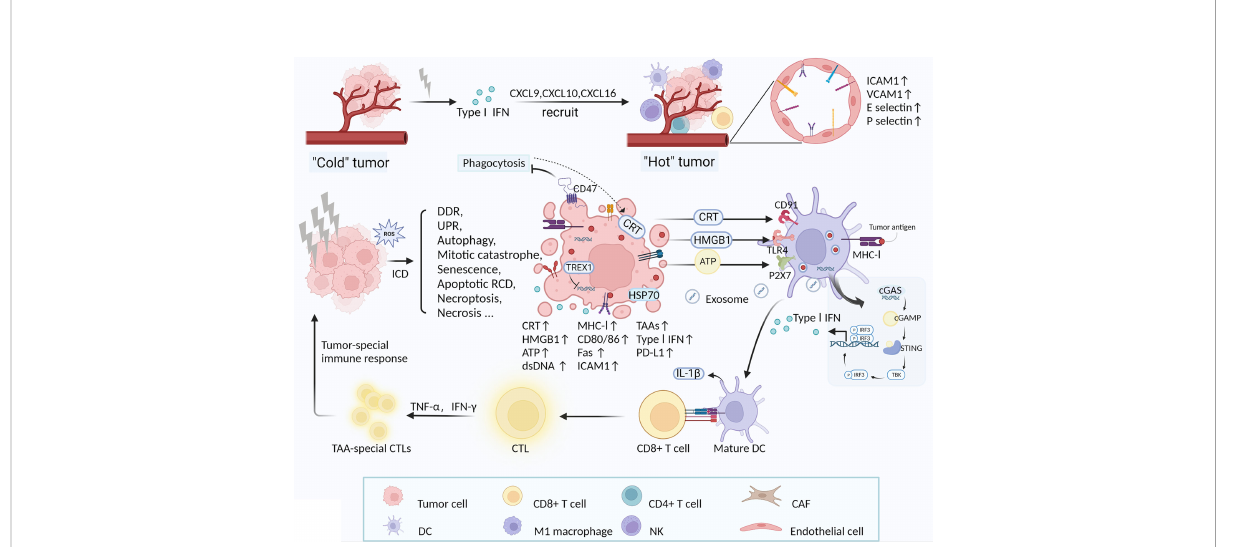
FIGURE 2 RT-induced increase in immune cells in TIME and tumor-special immune response activated by ICD. LDRT induces increased expression of a variety of molecules, including in fl ammatory cytokines (type I IFN), chemokines (CXCL9, CXCL10, CXCL16), adhesion molecules (ICAM1 and VCAM1) and E-/P-selectin, which facilitate the recruitment of multiple immune cells (DCs, NK cells, M1 macrophages, CD8 + and CD4 + T cells) (92, 94, 191, 193, 195). Concurrently, RT-induced vascular normalization also promotes immune cell in fi ltration in the TIME (181). Ultimately, RT transforms “ cold ” tumors (lymphocyte de fi ciency) into “ hot ” tumors sensitive to immunotherapy. RT directly or indirectly causes DNA damage in tumor cells and induces various forms of cellular responses and death, such as DDR, UPR, autophagy, mitotic catastrophe,